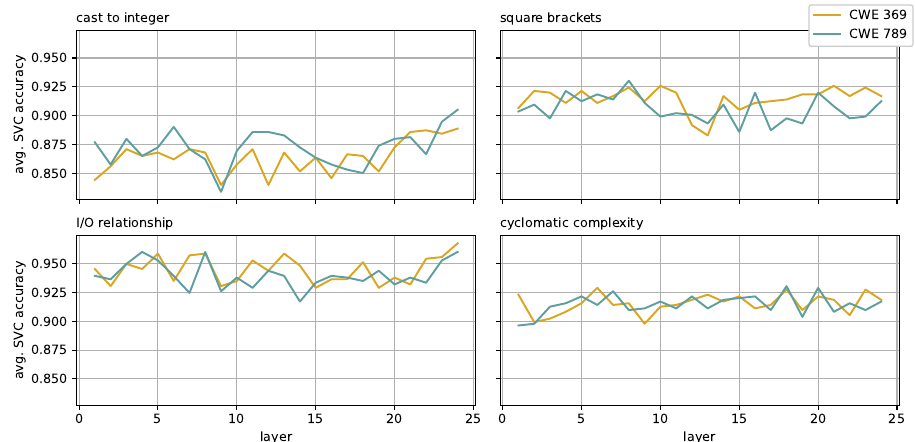
Figure 5. Average accuracies obtained over 10 runs by the linear SVCs trained on different